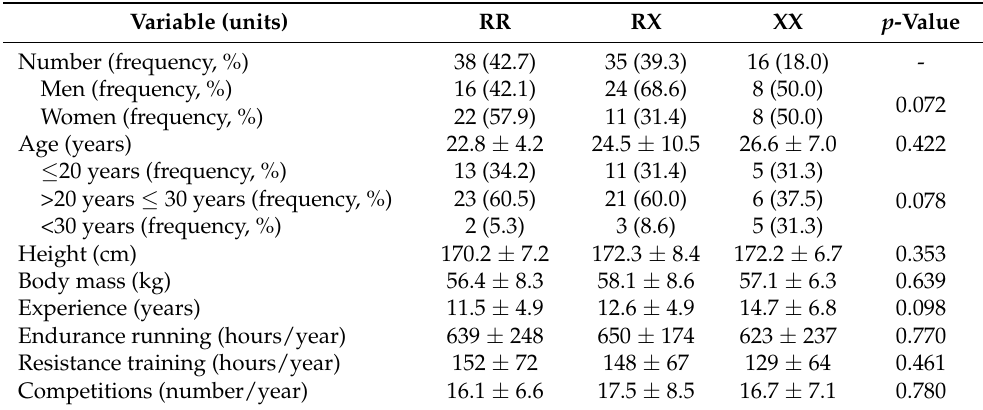
Table 1. Age, anthropometric characteristics, running experience, and training status of Spanish elite endurance athletes with different ACTN3 R577X